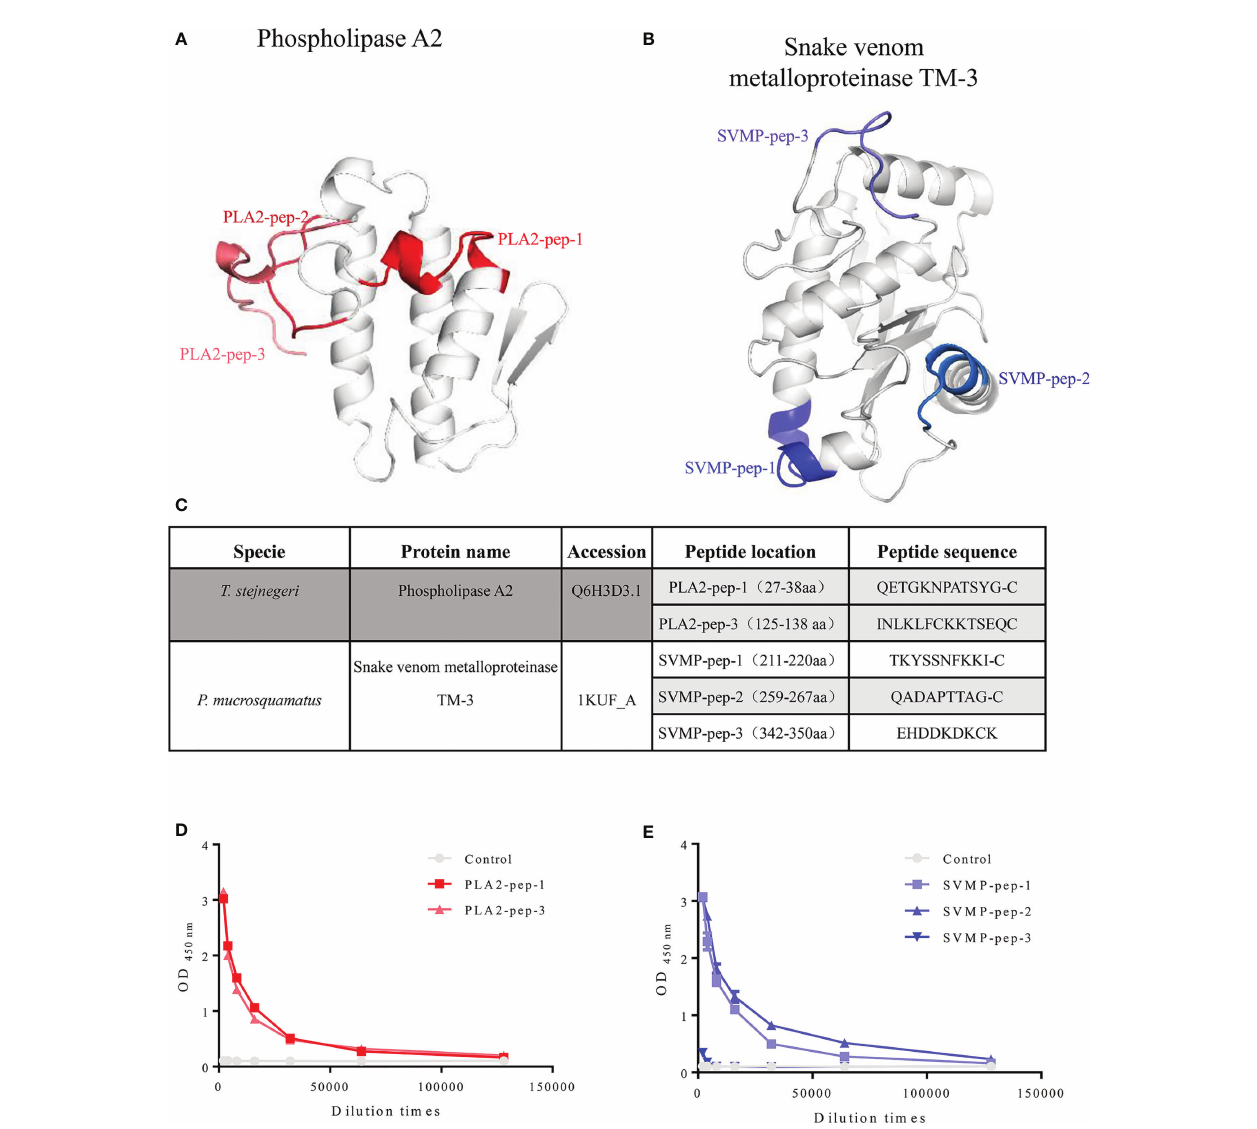
FIGURE 2 | Information on peptide antigens. Structures of phospholipase A 2 (access: Q6H3D3.1) and snake venom metalloproteinase TM-3 (access: 1kuf) of T. stejnegeri and P. mucrosquamatus , respectively, were obtained from the Protein Data Bank. After analysis of amino acid sequences, antigen immunogenicity, and three-dimensional structure of phospholipase A 2 and snake venom metalloproteinase TM-3, respectively, the genus-speci fi c antigenic peptides of phospholipase A 2 and snake venom metalloproteinase TM-3 were obtained. Three peptide antigens of PLA 2 (i.e., PLA2-pep-1, PLA2-pep-2, and PLA2-pep-3) and three peptide antigens of SVMP (i.e., SVMP-pep-1, SVMP-pep-2, and SVMP-pep-3) were obtained. Peptide PLA2-pep-2 was shielded by PLA2-pep-1, and thus, antigen PLA2- pep-2 was discarded (A , B) . Peptide antigens were synthesized, and cysteine was added to the peptide sequence for KLH – peptide complex antigen preparation if the chosen peptides did not contain cysteine at the C-terminal (C) . Based on ELISA of peptide antigen-coated plates, the titers of puri fi ed pAbs-p (1 mg/ml) against PLA2-pep-1, PLA2-pep-3, SVMP-pep-1, and SVMP-pep-2 were 1:64,000 or more, while the titers of anti-SVMP-pep-3 were only 1:1,000 (D , E)